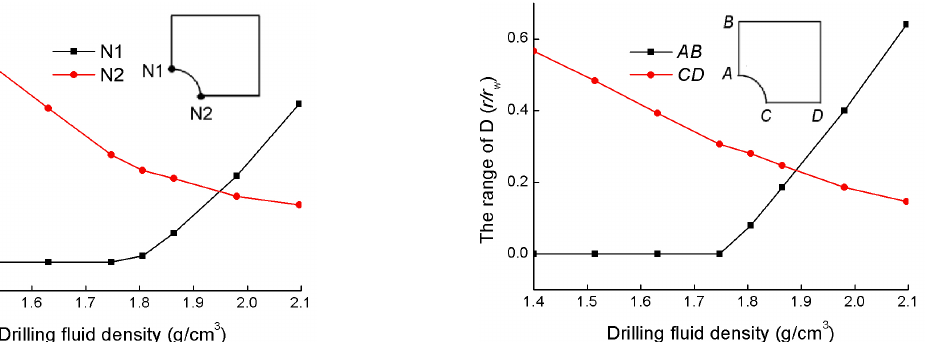
Figure 12: The range of damage at different drilling fluid